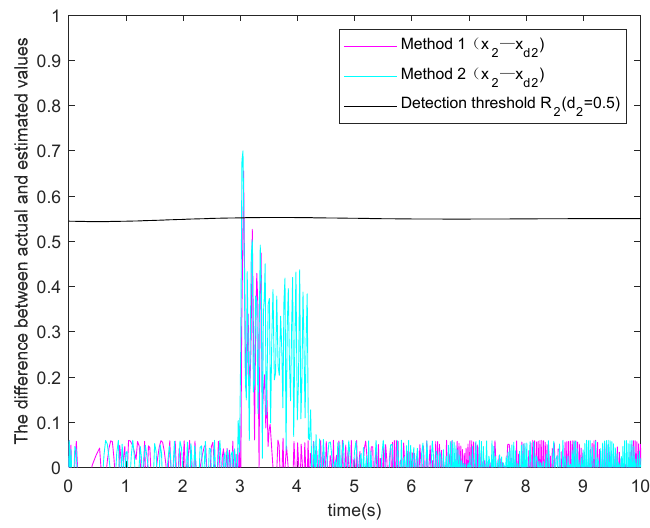
Figure 7. Fault tolerant control of the interconnection fault of subsystem 2.